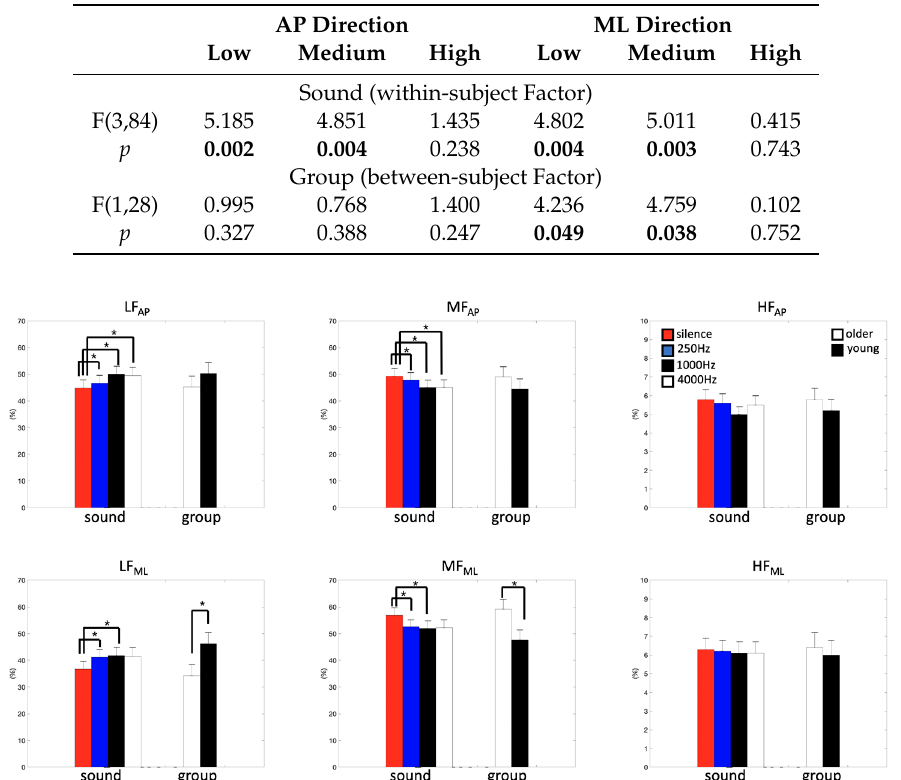
Figure 2. The effects of sound and group on the low-frequency (LF), the medium-frequency (MF), and the high-frequency (HF) bands of the center of pressure (COP) power spectrum in the anterior-posterior (AP) (upper panels) and medial-lateral (ML) (lower panels) directions. Mean and standard errors are shown. * shows statistical significance ( p < 0.05).